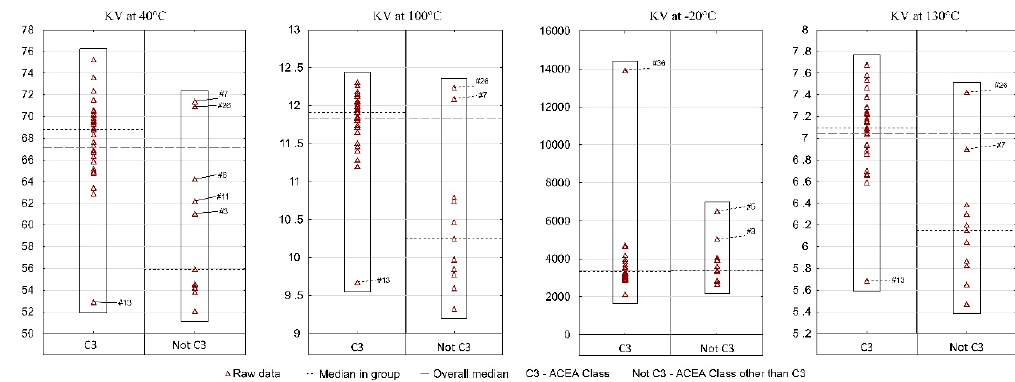
Figure 6. Kinematic viscosity of fresh engine oils in the aspect of ACEA Class.